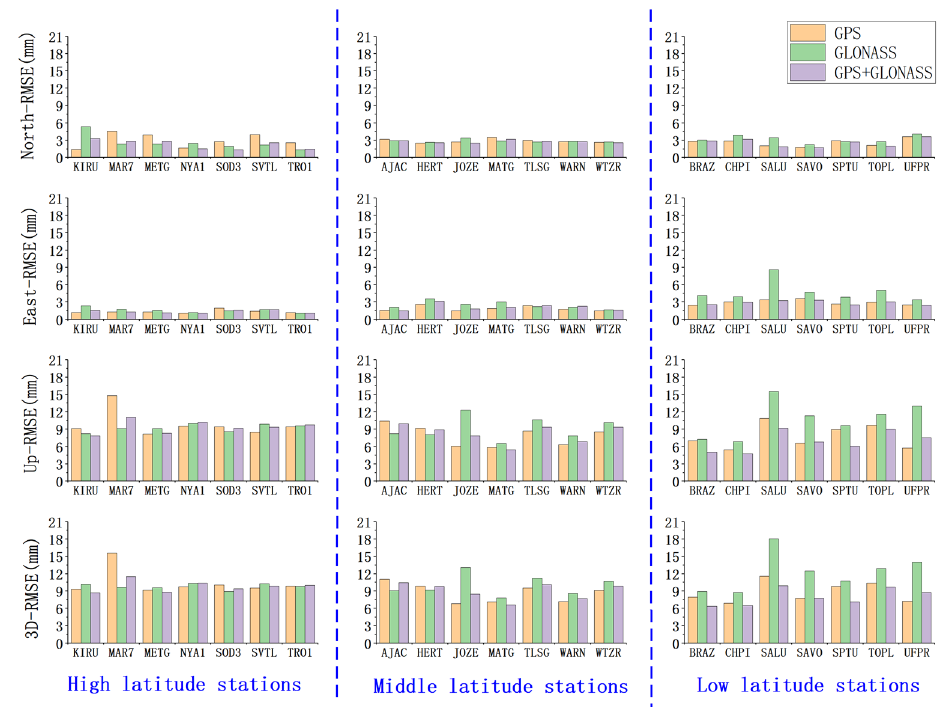
Figure 9. The RMSE of coordinates estimated with DD processing.